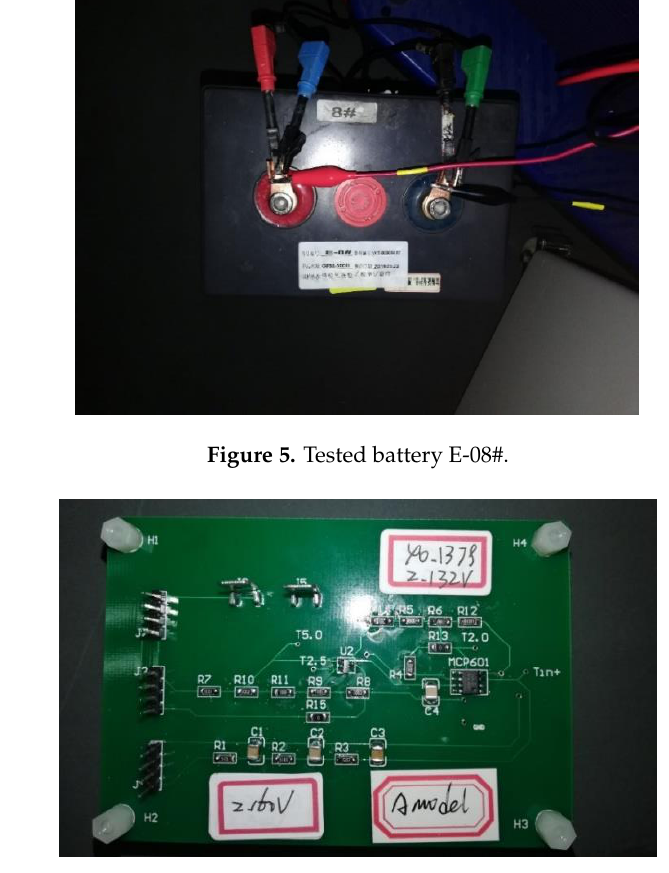
Figure 6. Detection circuit of steady-state DC static over-potentials on batteries’ terminals.